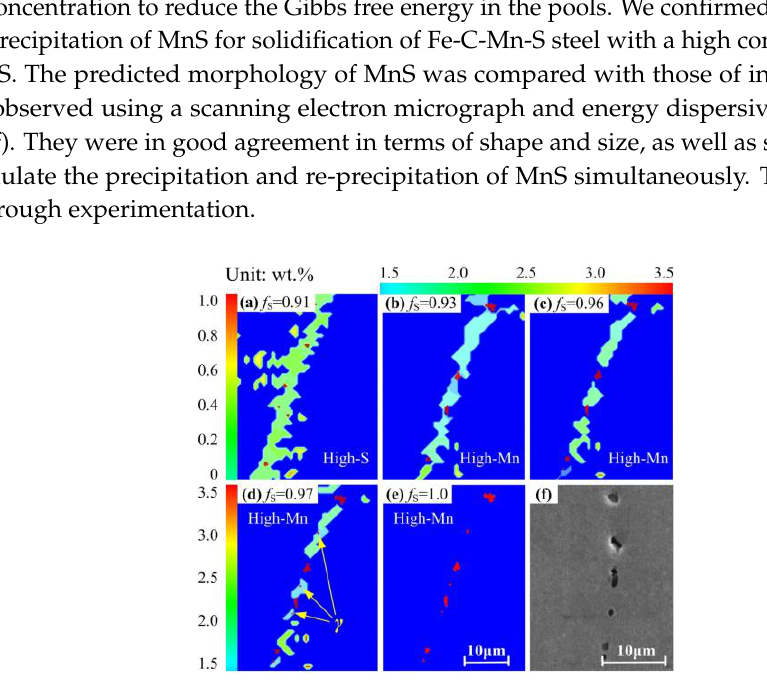
Figure 8. MnS precipitation in Part B and its comparison with experimental observations.